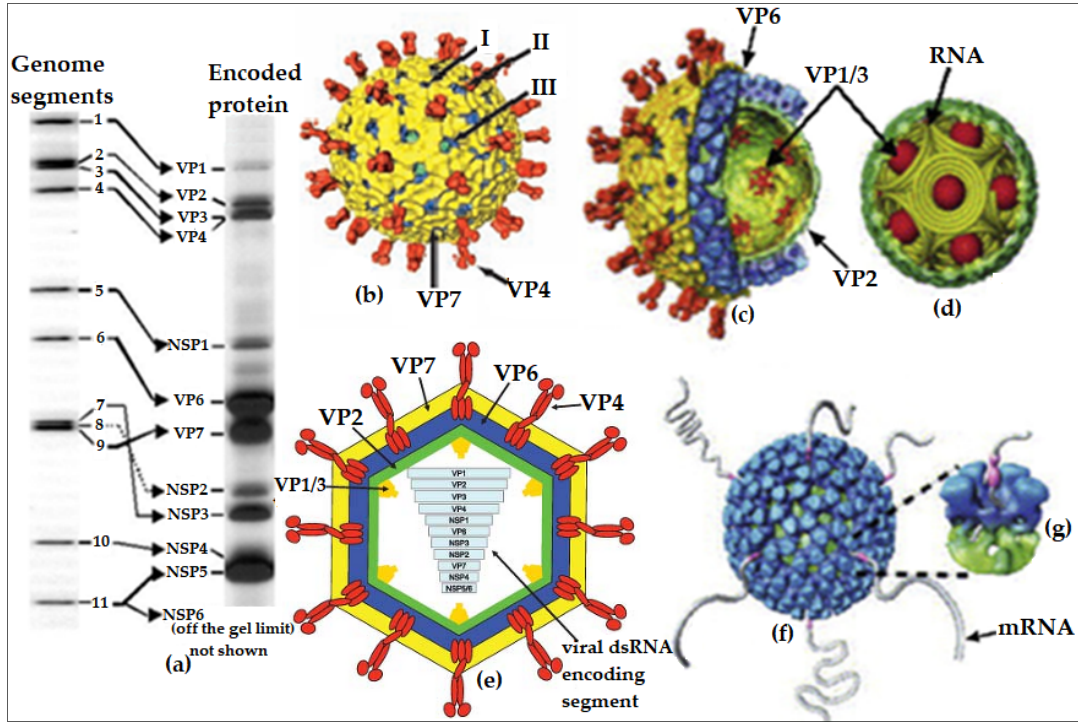
Figure 1. Detail illustration of rotavirus particle and its segmented dsRNA genome encoding protein: ( a ) Electrophoretic pattern of rotavirus group A (RVA) individual segmented genomic RNA with their corresponding encoded proteins. The proximity of segments 7, 8, and 9 represents the identity of rotavirus electrophoretic pattern; ( b ) cryo-electron microscopy reconstruction (CEMR) of the rotavirus triple-layered particles (TLPs) with the spike-like protein VP4 and the outer-layer glycoprotein VP7 (shaded in yellow) with specific localisation of transcriptional pores—I, II, and III; ( c ) a semi-longitudinal section of TLPs showing the inner capsid (VP6) and core protein (VP2) layers and the transcriptional enzymes accessories (VP1 and VP3) enclosed by the VP2 core protein; ( d ) genomic organisation in rotavirus core protein (VP2) with intricate transcriptional enzymes enclosed inside the protein coat; ( e ) complete longitudinal section of rotavirus TLPs showing the chronological arrangement of the segmented genomes (VP1 to NSP5 / 6); ( f , g ) model from CEMR of transcribing double-layered particles (DLPs) showing the endogenous transcription, which results in the simultaneous release of the transcribed mRNAs. Figures adapted and modified from [12,13] with permissions.